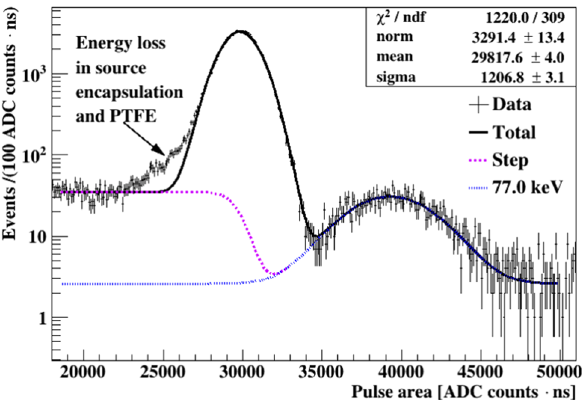
Fig. 10 Gaussian fitting of the 59.5 keV γ -ray peak on top of a flap background, the tail of the 77 keV peak and a smeared step function